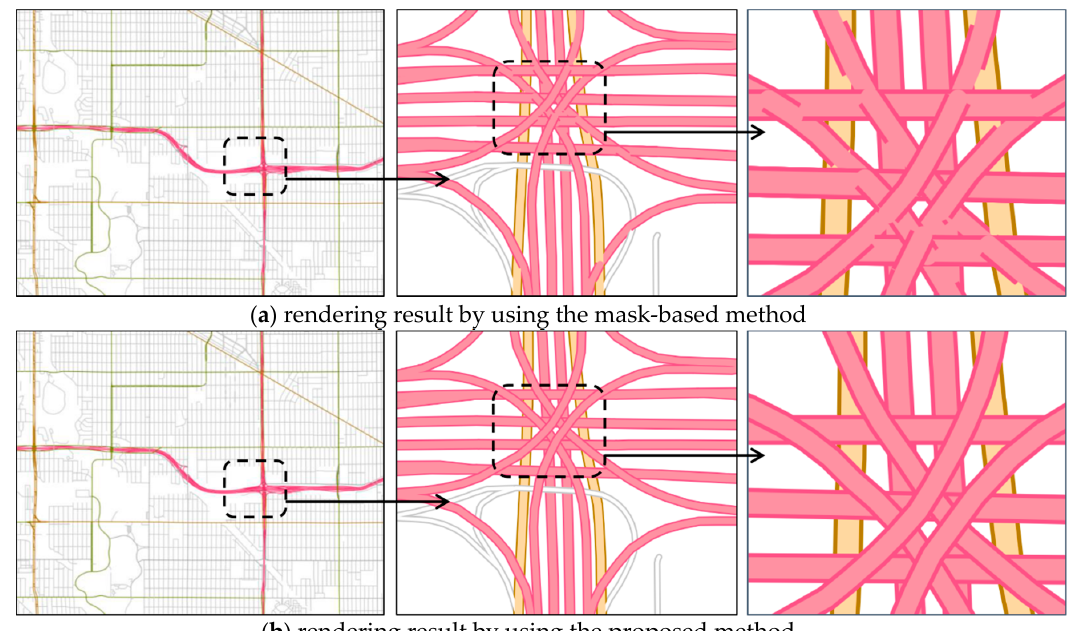
Figure 16. Rendering results for the second sample dataset.